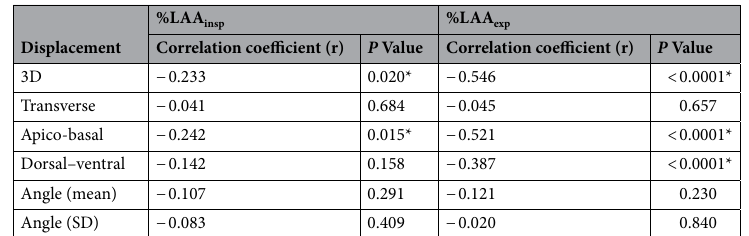
Table 3. Results of correlation test between %LAA and magnitude, angle of displacement vectors in emphysema patients. P values with asterisk* indicate to be statistically